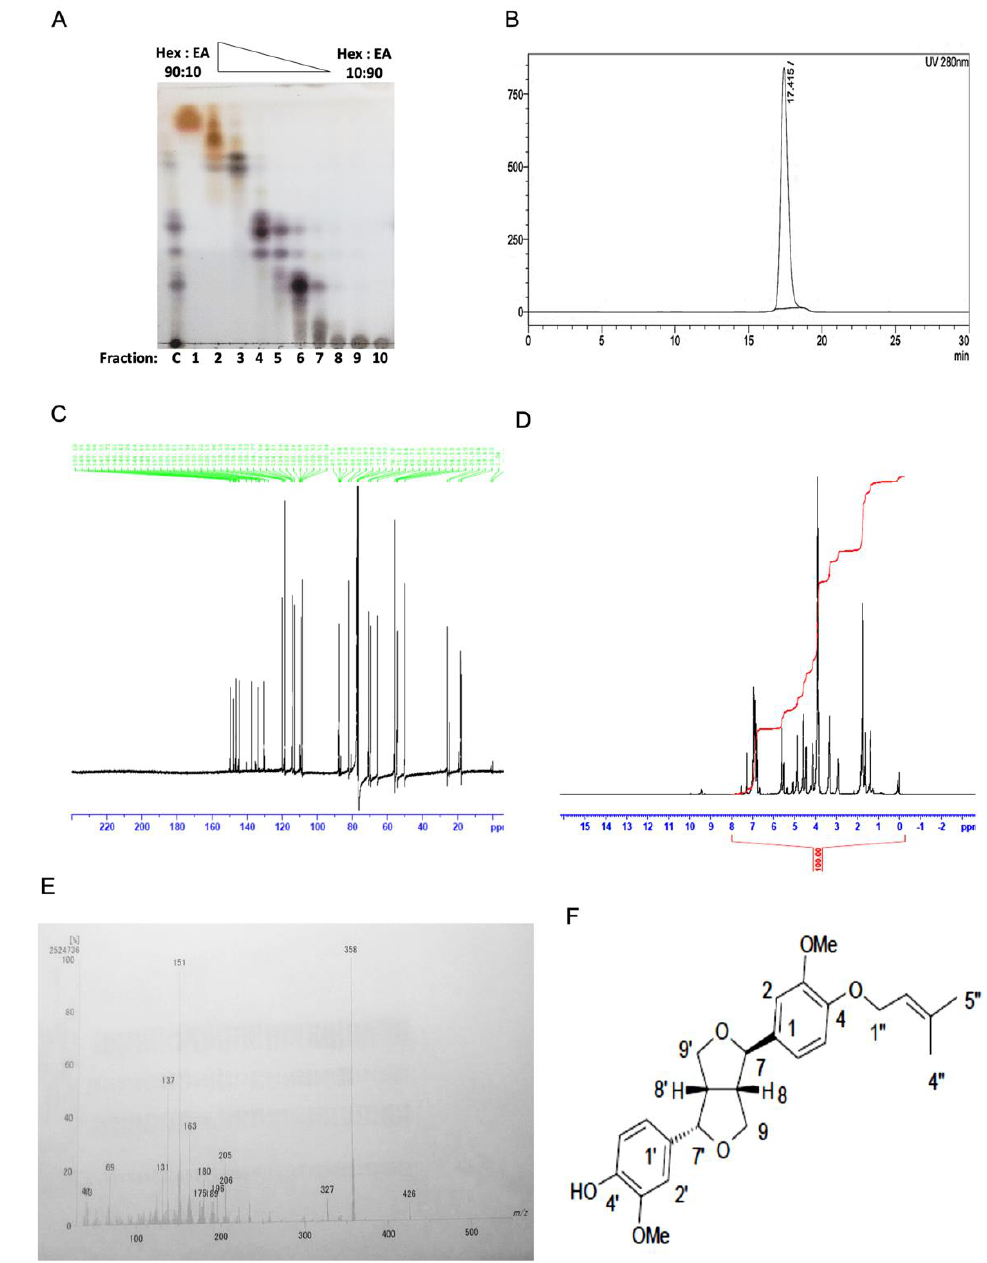
Figure 2. Characterization of bioactive compounds. ( A ) TLC chromatograms of bioassay-guided purification from silica gel column chromatography. Eluent of (90–10) % Hexane to (10–90) % Ethyl acetate gradient were used to elute the fractions. The eluted fractions (1–10) and crude methanol extract ( C ) were analyzed by TLC, using 60 F254 silica gel at room temperature. TLC was run at